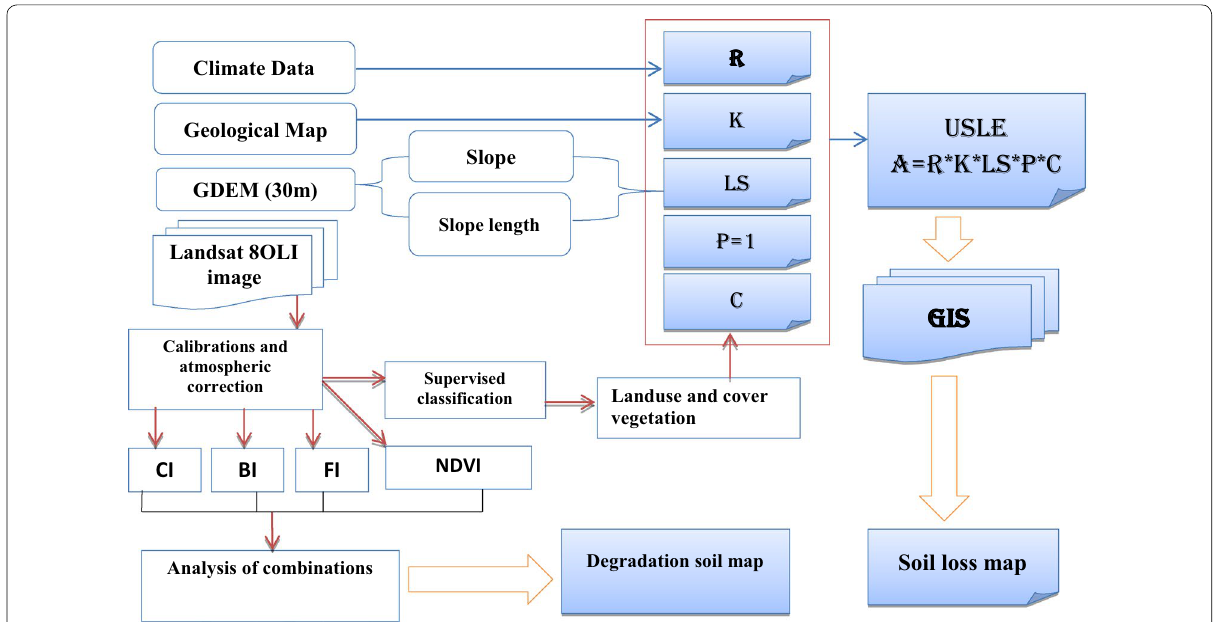
Fig. 2 Methodology